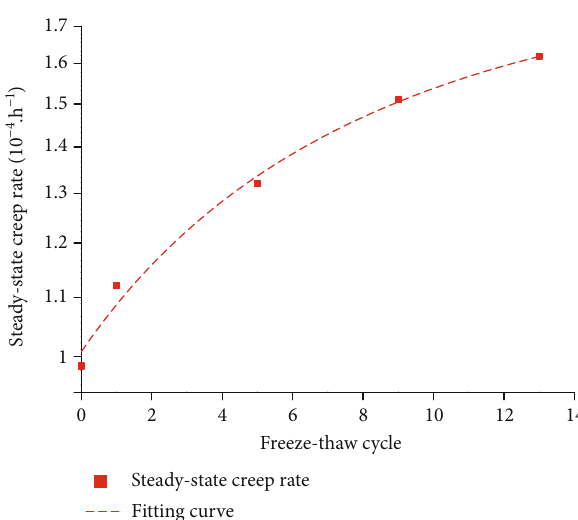
Figure 15: Curve of the steady-state creep rate versus the number of freeze-thaw cycles at the fourth loading stress level under 2 MPa of con fi ning pressure.